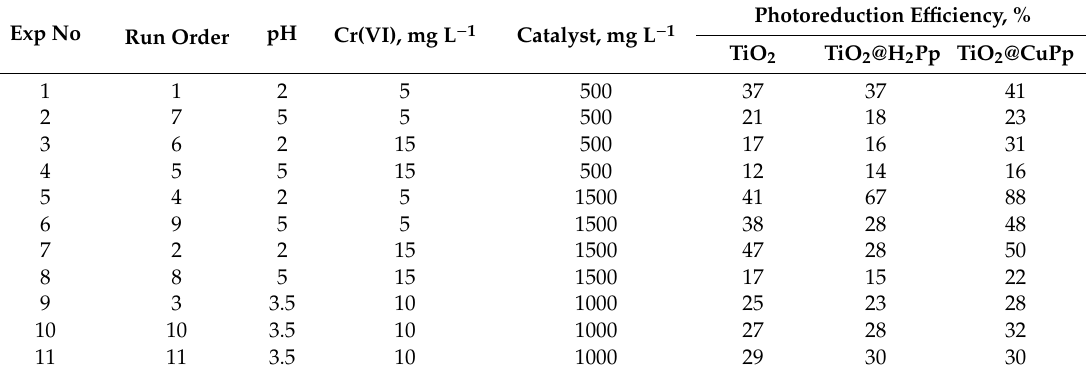
Table 2. Experimental model matrix obtained for the TiO 2 , TiO 2 @H 2 Pp, and TiO 2 @CuPp catalysts. Responses were collected after 60 min of irradiation.